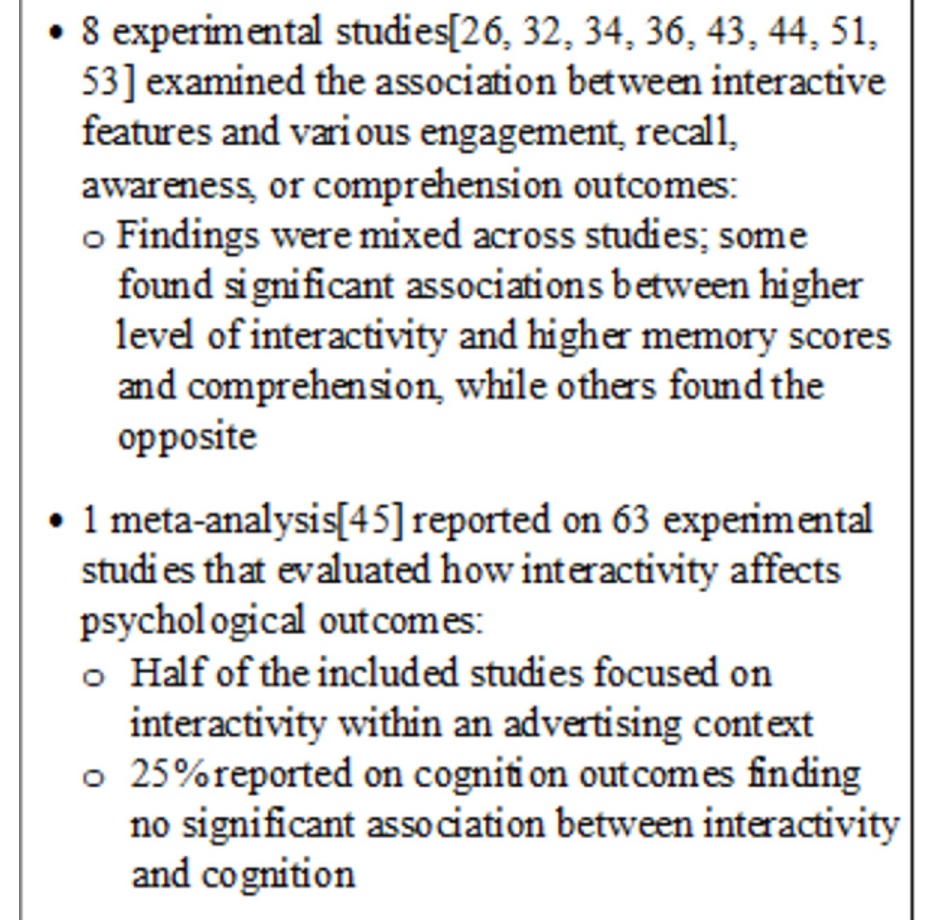
Fig 4. Summary of findings from 9 studies addressing research question